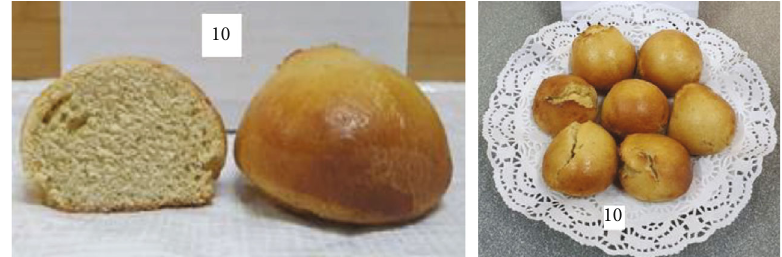
Figure 11: Sample no. 10 made from 5% mu ffi n and 15% chickpea fl our with 40 g of sugar beet powder added.